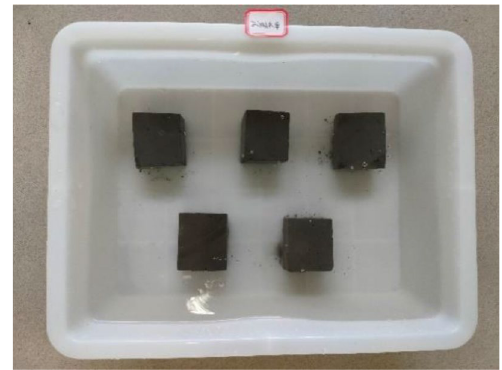
Figure 7. Samples soaking for 24 h.